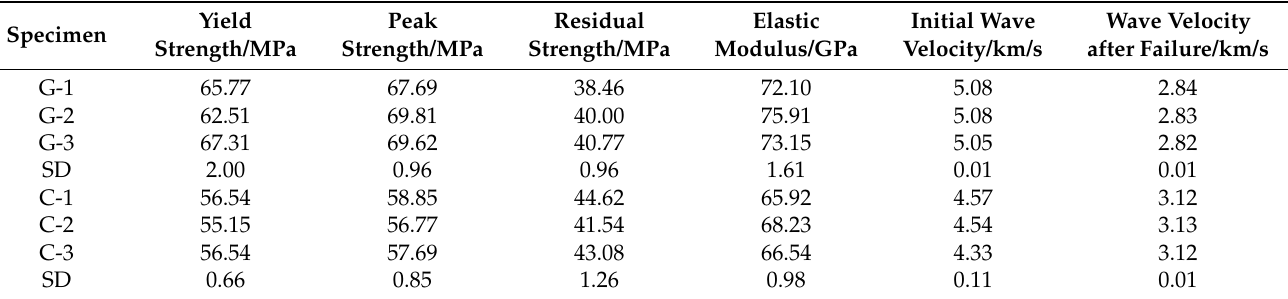
Table 3. Statistical table of mechanical